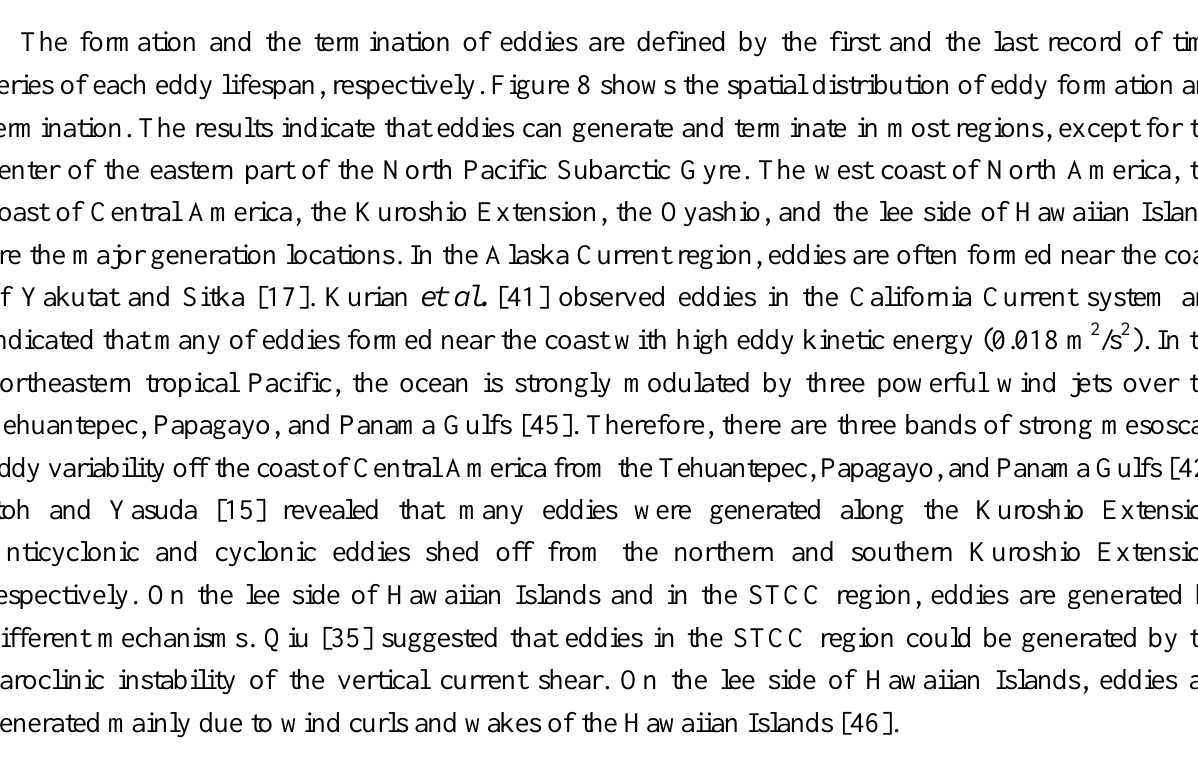
Figure 8. Statistics for eddies with lifespan more than or equal to 4 weeks showing the numbers of ( a ) eddy generations and ( b ) eddy terminations for each 1° × 1° region over a 20-year